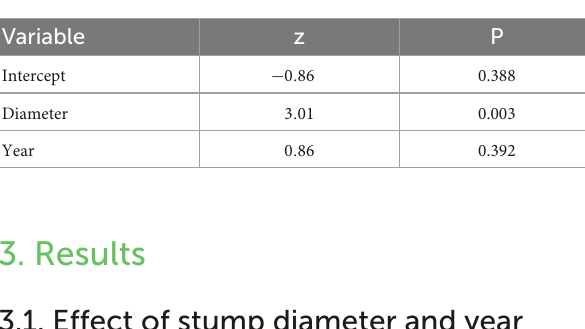
TABLE 3 Results of the influence of the studied independent variables on the attack intensity of the oak pinhole borer in the